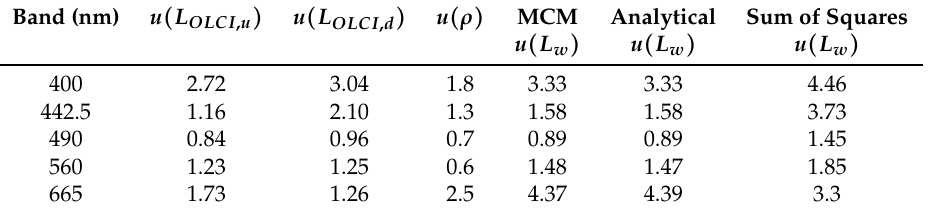
Table A3. Uncertainty evaluation methods comparison results. The first four columns are the uncertainty of the input components, followed by the uncertainty of the water-leaving evaluated using the MCM. All uncertainties here are presented as percentages. The analytical result calculates L w according to Equation (A2) and sum of squares using Equation (A4). The 778.8 and 865 nm bands are not included due to them having a water-leaving radiance of 0 and hence no meaningful